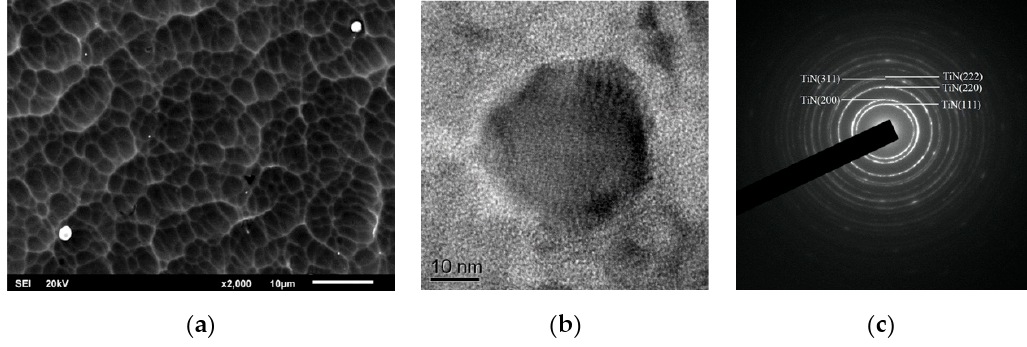
Figure 1. SEM images of surface, ( a ) high-resolution electron microscopic images of the coating structure, ( b ) and TEM patterns ( c ) of the Ti–Al–Cu–N coatings.